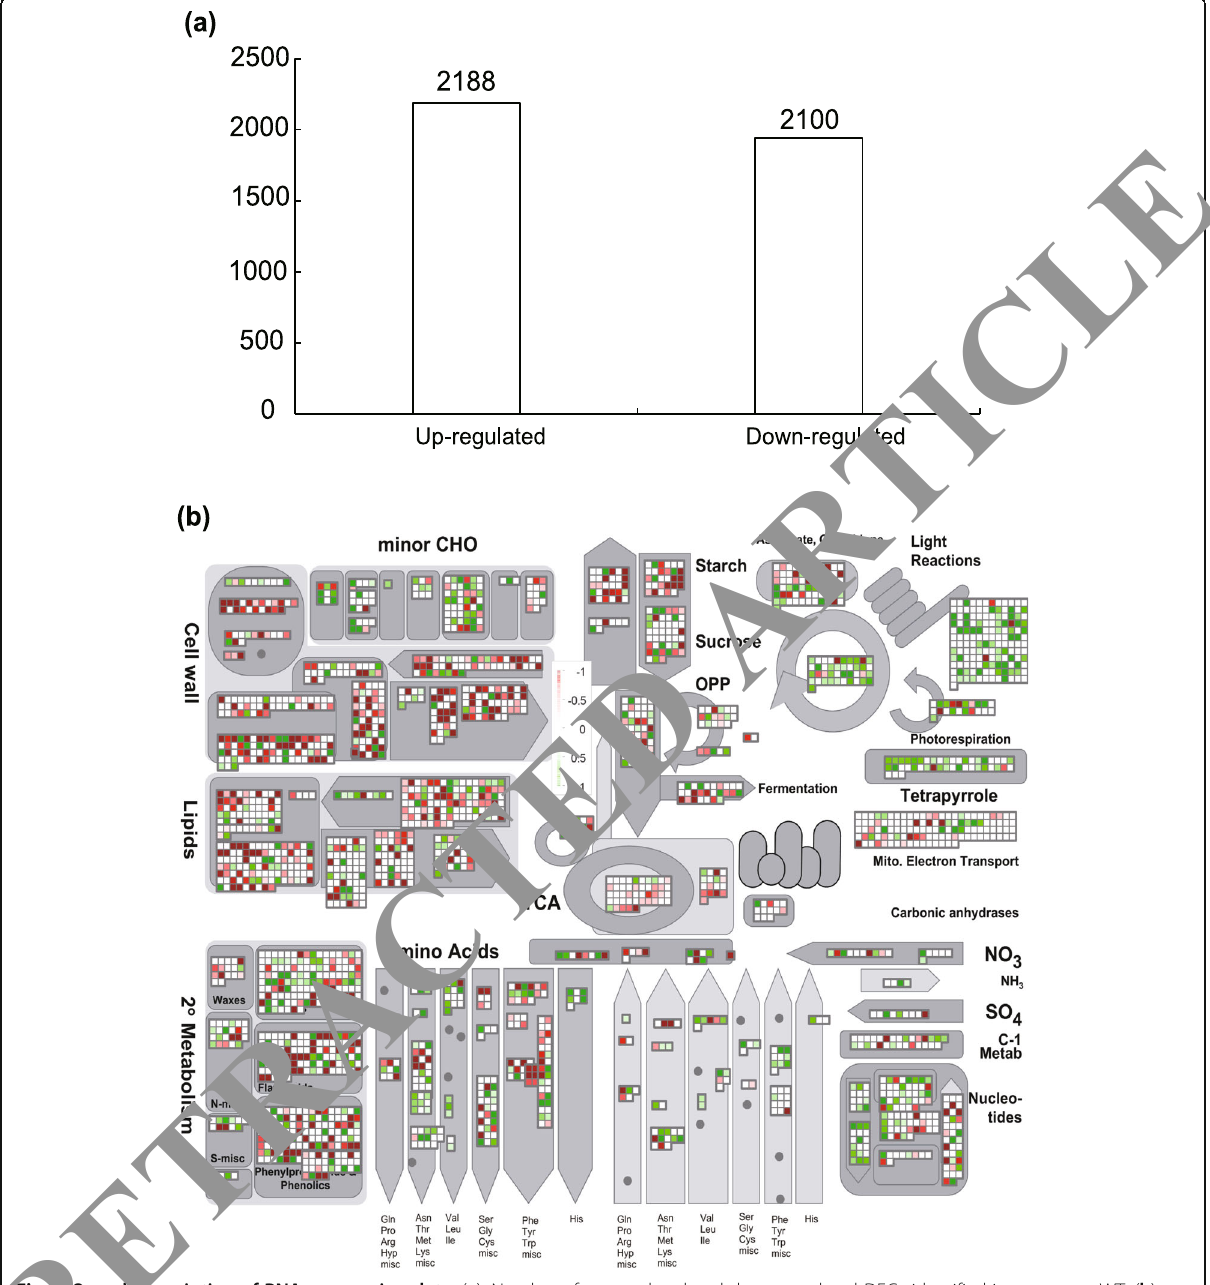
Fig. 2 Overall description of RNA-sequencing data. ( a ), Number of up-regulated and down-regulated DEGs identified in mutant vs WT. ( b ), Overview of transcript abundance changes in oslil3 and WT in MapMan assigned pathway genes. Each gene is represented as one colored square in the metabolic map, with red representing downregulation and green representing upregulation. The color scale is based on log 2 (fold change) values of